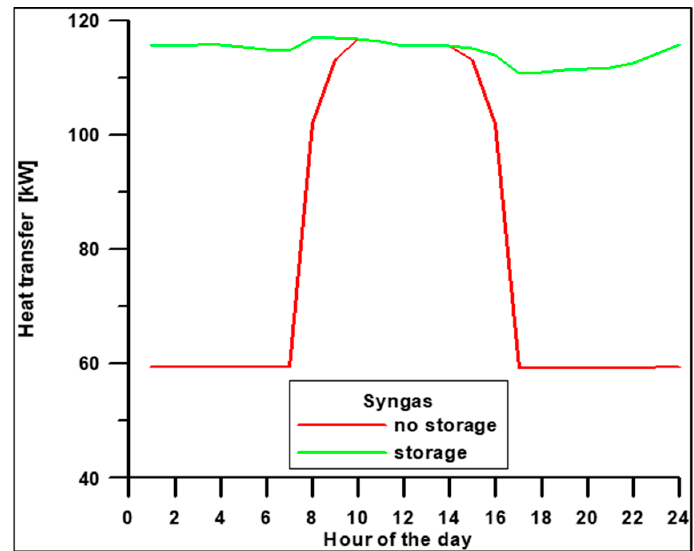
Figure 7. Heat transferred to Heat Recovery Unit.